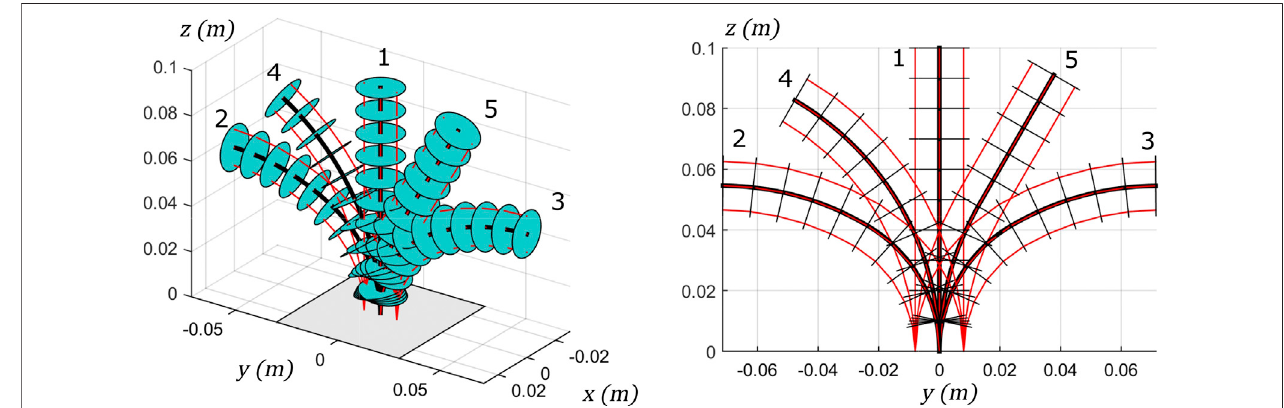
FIGURE 9 | Subset of the TDCR con fi gurations considered in the model comparison, for n (cid:1) 5 and without external forces at the tip. Left: 3D view, Right: Planar view.Maximumorzerotendontensionisappliedtoeachtendonforthetwosegments. [ T 1 , T 2 , T 3 , T 4 ] (cid:1) 1: [ 0 , 0 , 0 , 0 ] ,2: [ T M , 0 , T M , 0 ] ,3: [ 0 , T M , 0 , T M ] ,4: [ 0 , 0 , T M , 0 ] ,5: [ 0 , T , 0 , 0 ] . The backbone is represented in black, the spacer disks in blue and the tendons in red. M